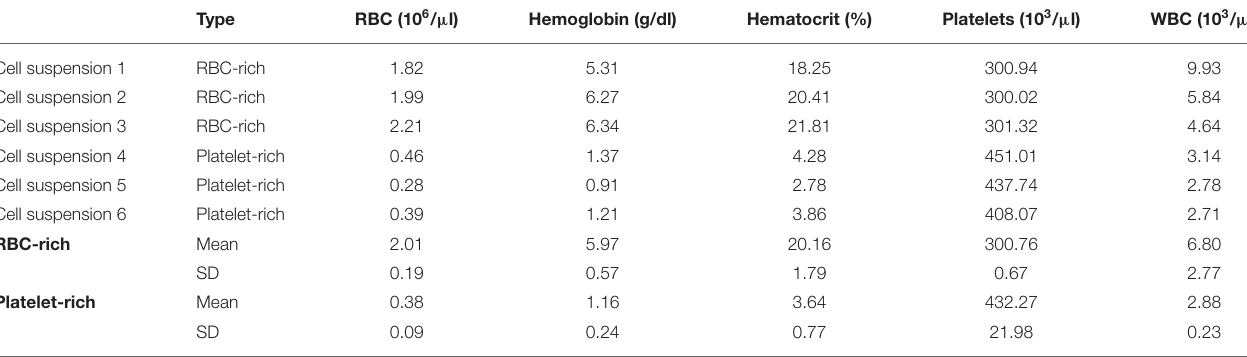
TABLE 1 | Composition of blood cell suspensions for the preparation of red blood cell- or platelet-rich thrombi.